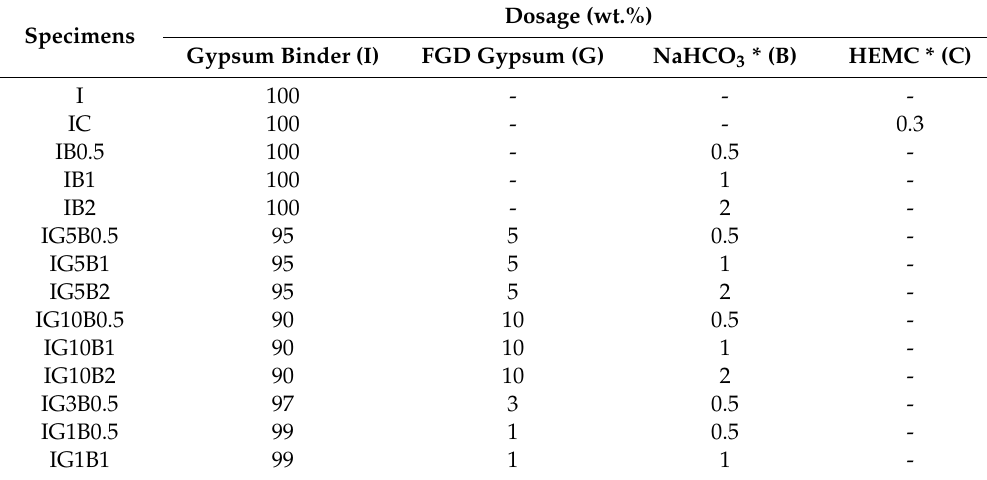
Figure 1. XRD patterns of flue gas desulfurization (FGD) gypsum. Table 1. Composition of studied